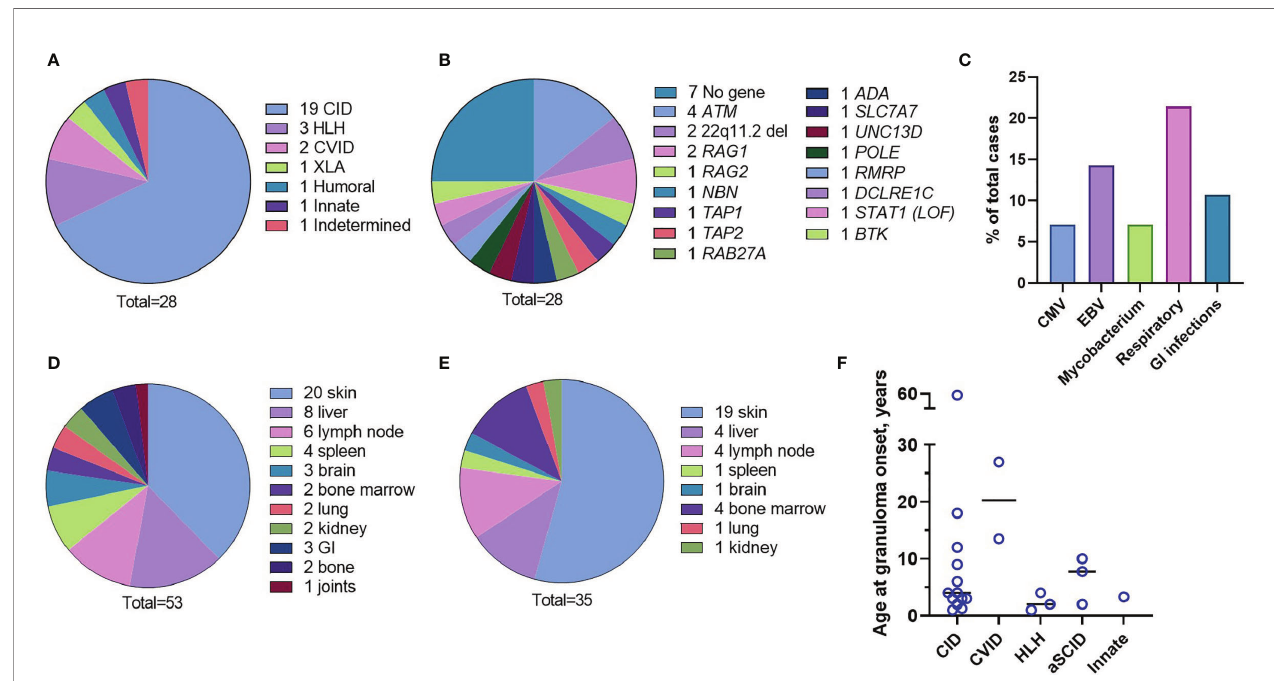
FIGURE 1 | Characteristics of the patient cohort. Underlying immunode fi ciencies (A) . Genetic causes (B) . Frequency of chronic infections (C) . Organs involved in in fl ammation (D) . Granuloma location at onset (E) . Age of the patients at the granuloma onset by the IEI type (F)